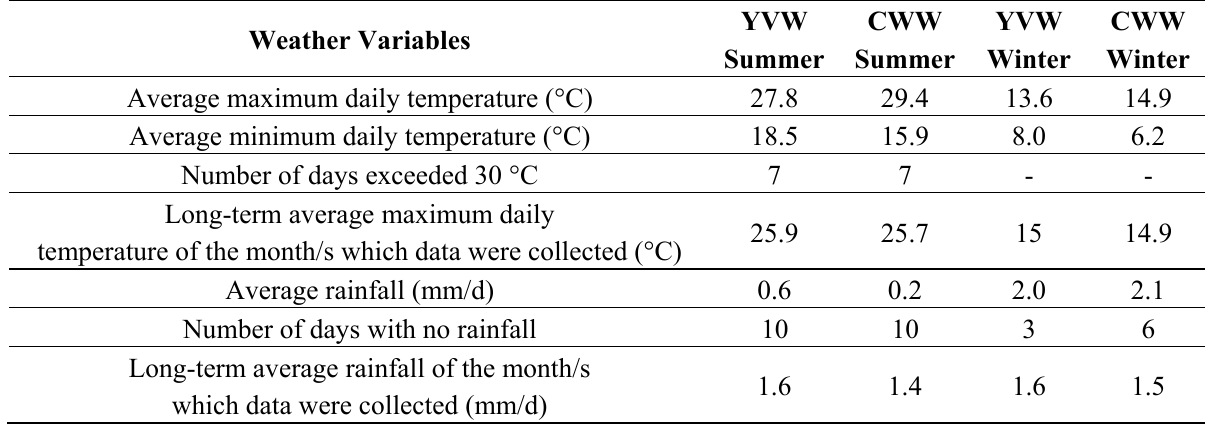
Table 2. Weather data in YVW and CWW area during summer and winter data collection period. YVW: Yarra Valley Water; CWW: City West